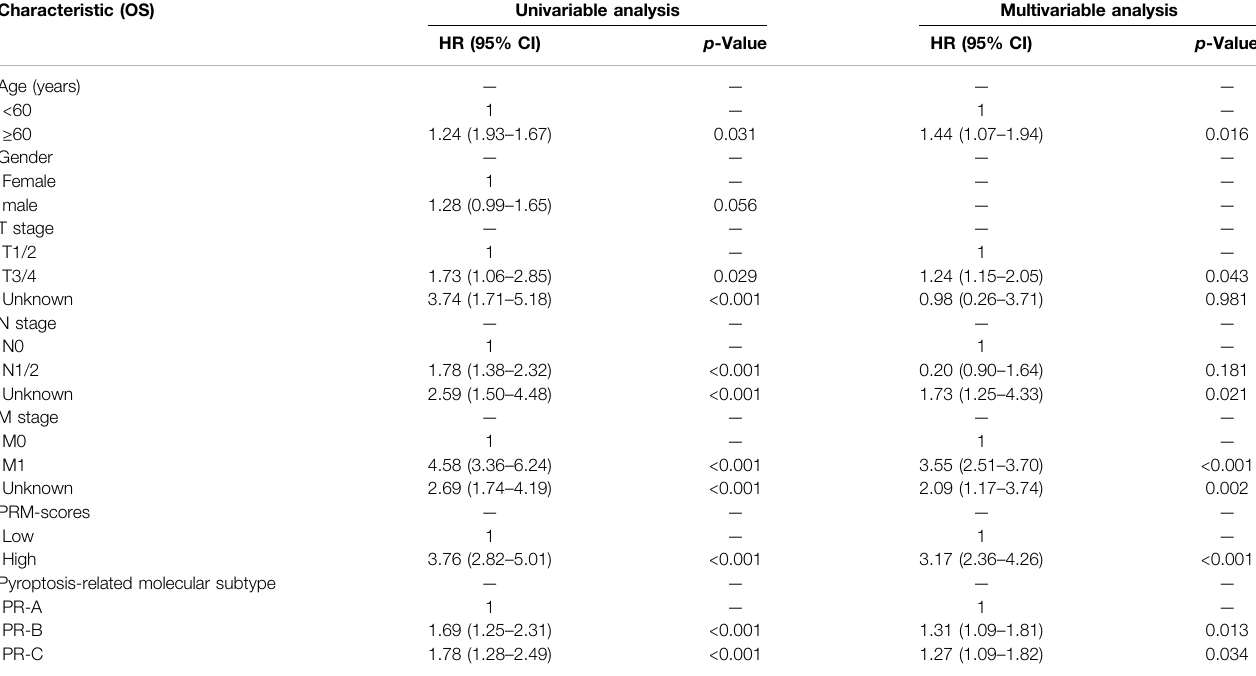
TABLE 1 | Univariable and multivariable Cox regression analyses of OS in CC patients. Characteristic